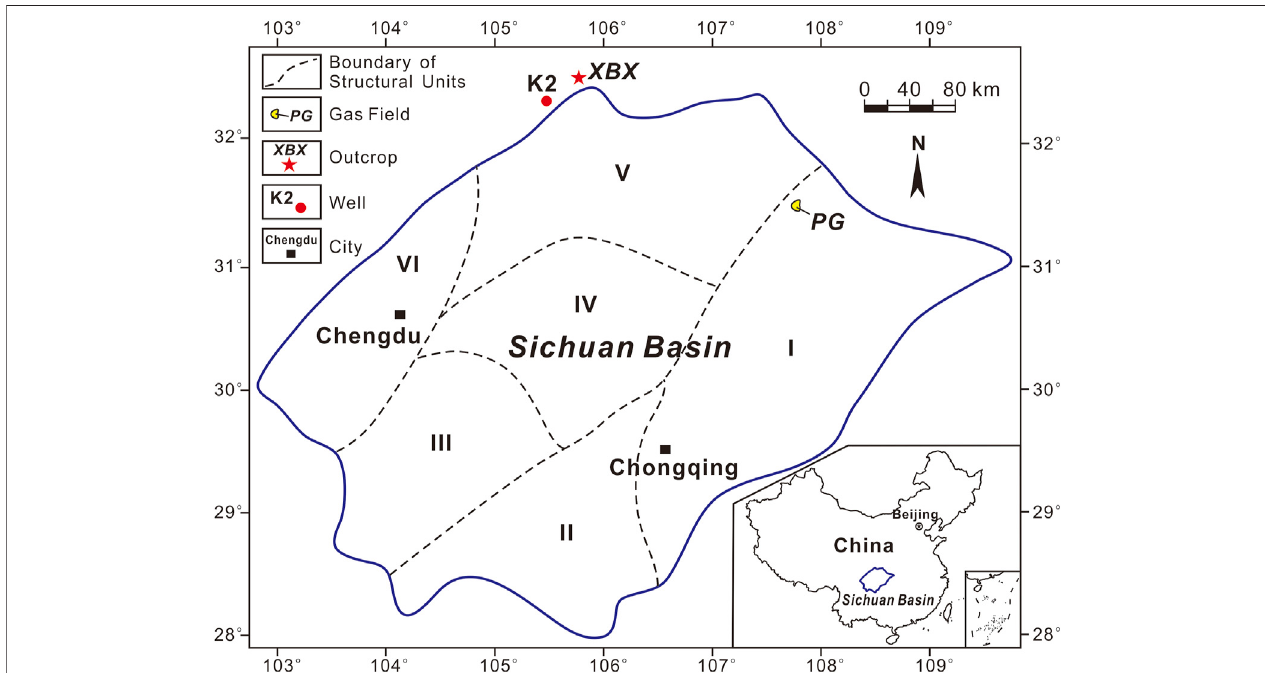
FIGURE 1 | Locations of the Puguang (PG) gas fi eld, well-K2, and the Xibeixiang (XBX) outcrop in the Sichuan Basin. I (cid:1) eastern complete fault-fold zone, II (cid:1) southern gentle fault-fold zone, III (cid:1) southwestern gentle fault-fold zone, IV (cid:1) central fl at zone, V (cid:1) northern gentle fault-fold zone, VI (cid:1) western gentle fault-fold zone.